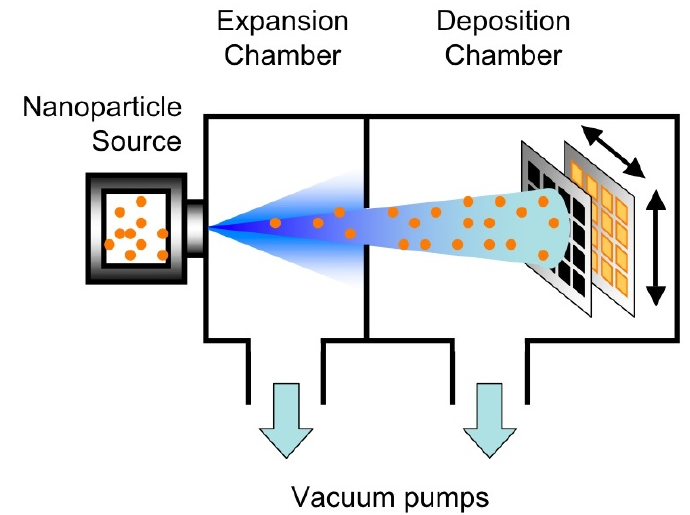
Figure 2. Schematic image of the apparatus for supersonic cluster beam deposition. It consists of a vacuum system, where nanoparticles are first generated by suitable sources, then immediately launched to deposition chamber by an expanding gas jet. In the present work, nanoparticles are generated by a PMCS. As schematically shown, beam collimation allows deposition patterning by non-contact hard-mask; deposition of many devices in batch is achievable by substrate rastering (as indicated by arrows).